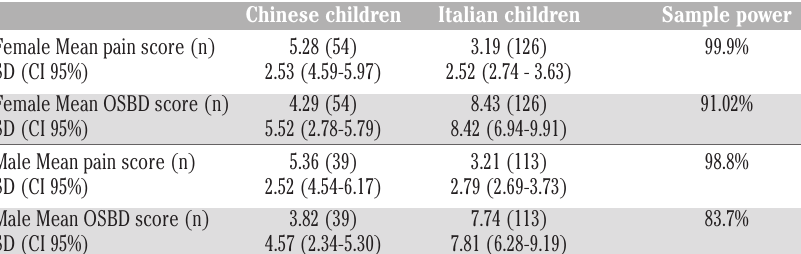
Table 5. Differences in the mean pain and Observational Scale of Behavioral Distress (OSBD) scores of Chinese and Italian children stratified by